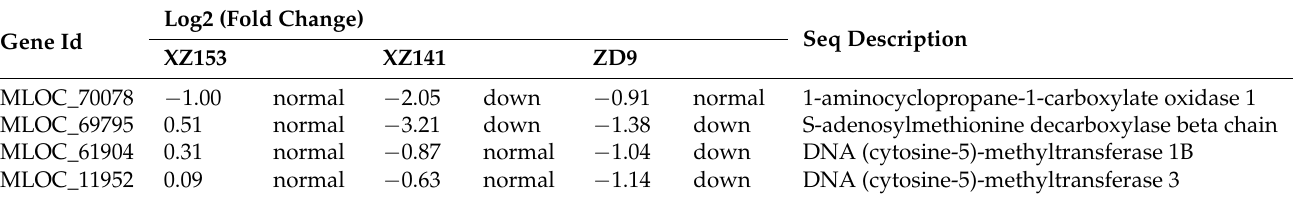
Table 2. The DEGs involved in SAM cycle and ethylene biosynthesis process at 15 d after LK stress.